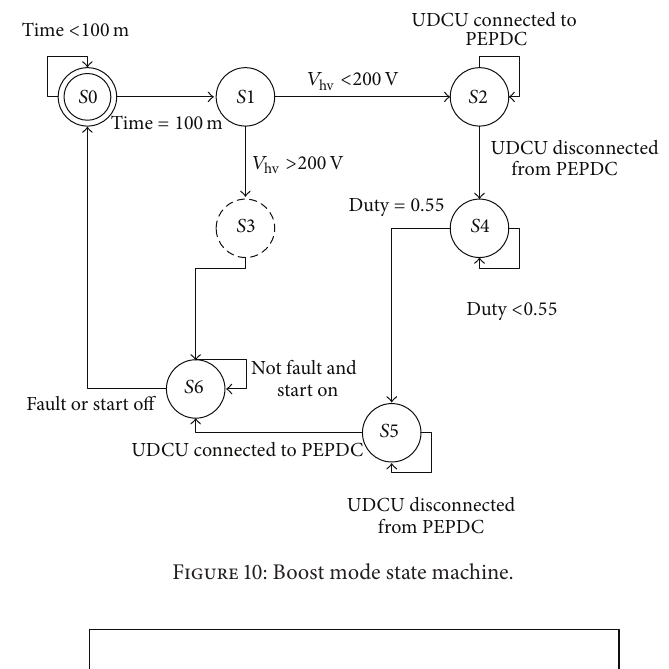
Figure 10: Boost mode state machine.